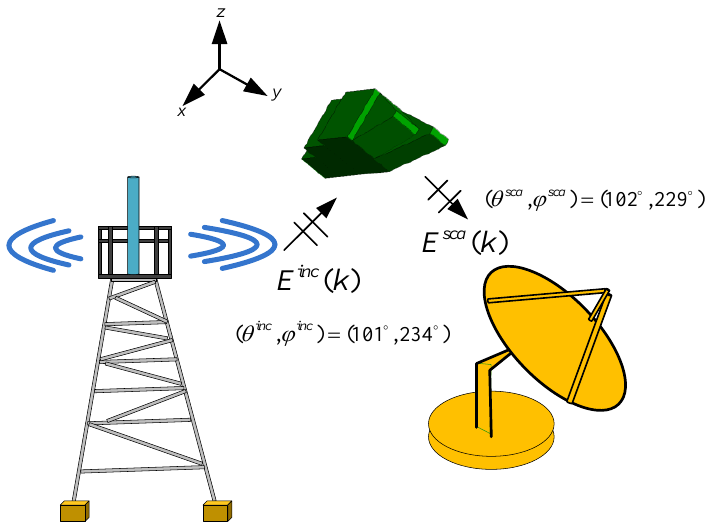
Figure 9. The posture of the coated boat based on Sub6 base station illuminator.